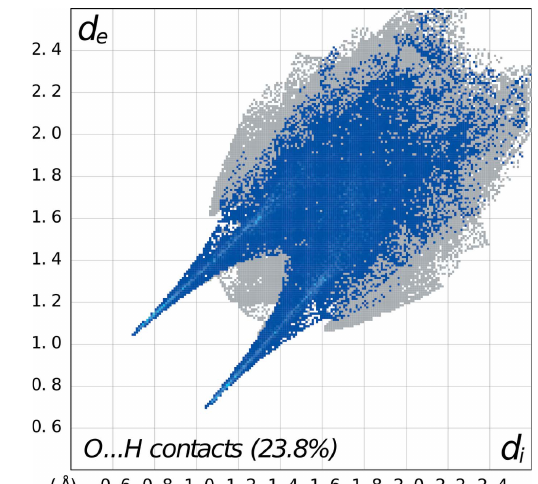
(20) motifs between rings B and C 2 Figure 8 (9) 3 Fingerprint plot for 2 delineated into O (cid:2)(cid:2)(cid:2) H/H (cid:2)(cid:2)(cid:2) O contacts showing the prominent spikes as N—H (cid:2)(cid:2)(cid:2) O